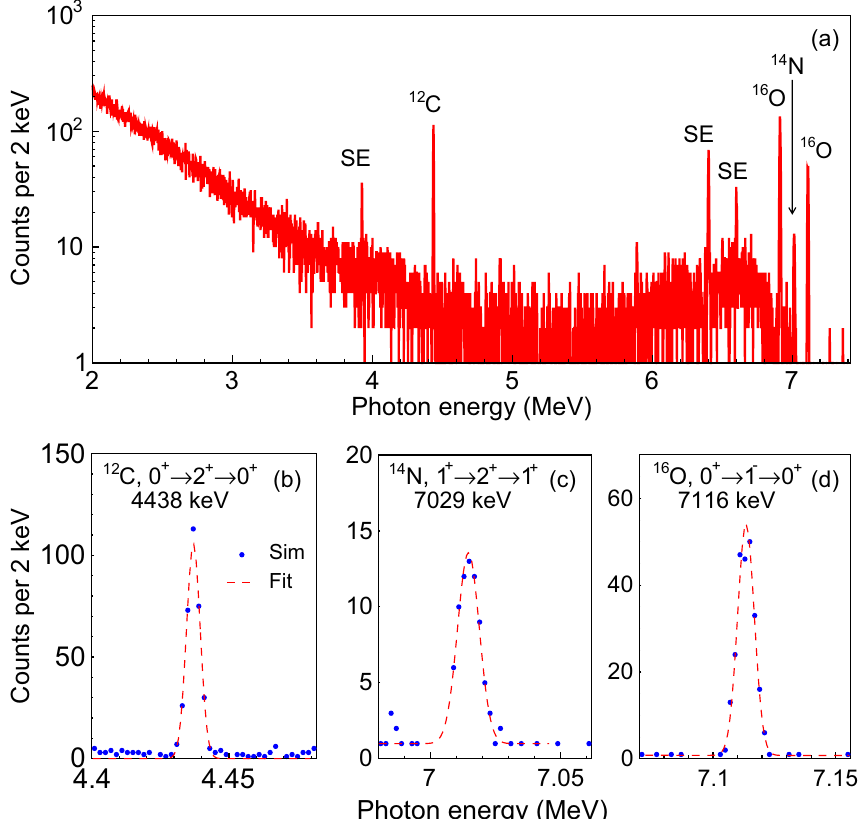
Figure 3. ( a ) Simulated NRF γ -ray spectra from the cocaine material without iron shielding. There are clear photopeaks at 4438, 6917, 7029 and 7116 keV at large S/N ratios, and three visible single-escape (SE) peaks. The cylinder target with a thickness of 10 cm, a radius of 5 cm and a density of 0.9 g/cm 3 and the γ -beam flux of 10 11 are used in the simulations. Three zoomed spectra showing the NRF signal regions around 4438 keV 12 C ( b ), 7029 keV 14 N ( c ) and 7116 keV 16 O ( d ), respectively. In pads ( b )–( d ), dash lines represent 5-parameter Gaussian peak plus linear background fits when considering a narrow region of ± 40